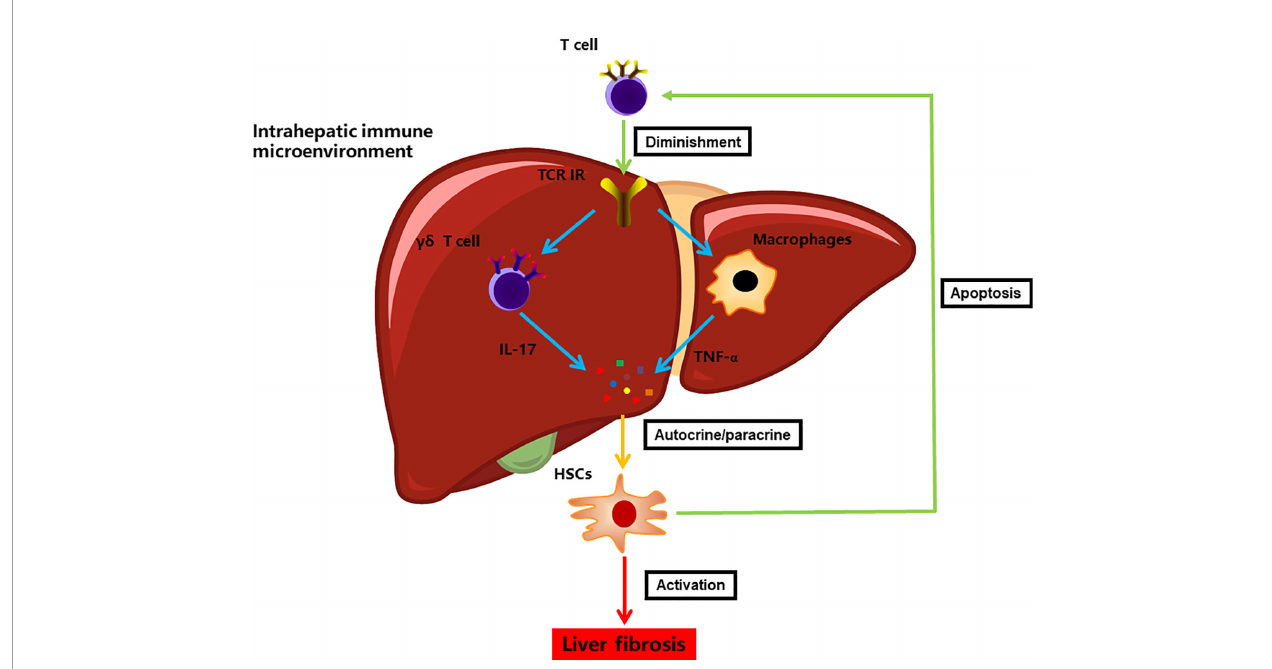
FIGURE 6 | A model illustrating the immune microenvironment of liver fi brosis in the context of TCR